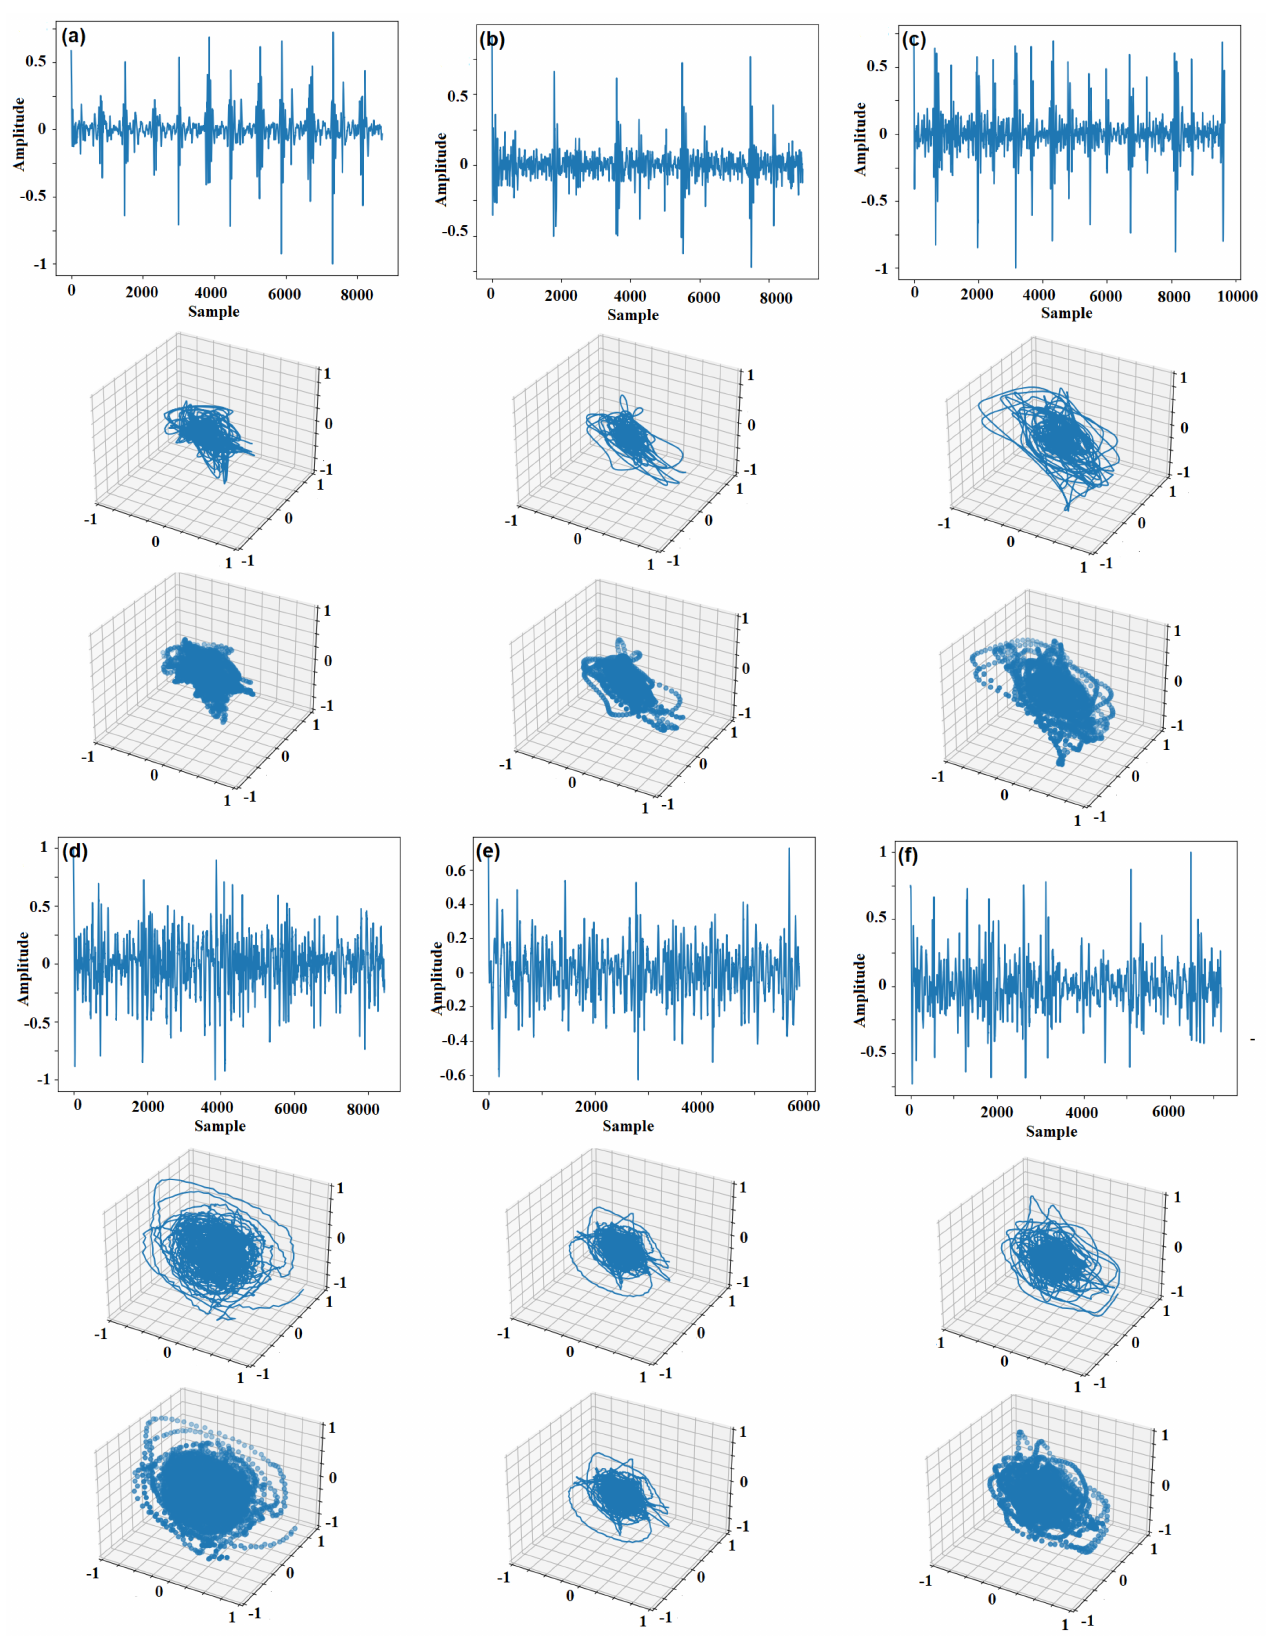
Figure 4. Six PCG signals and their representation in RPS with τ = 18 and d = 3: ( a – c ) are normal, and ( d – f ) are abnormal